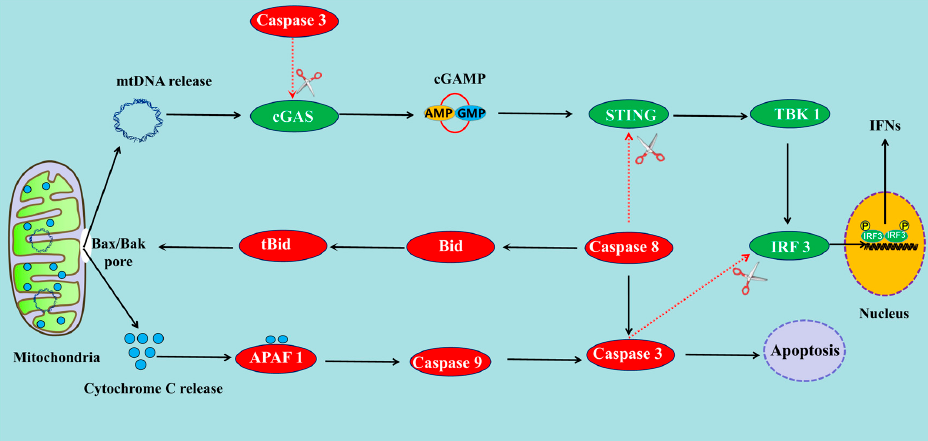
Figure 2. Apoptosis can feed back to regulate the cGAS-STING pathway. (1) Apoptosis can suppress the cGAS-STING pathway through the activation of caspases including caspase-3 and caspase-8. (2) Apoptosis can promote the cGAS-STING pathway through the release of mtDNA.